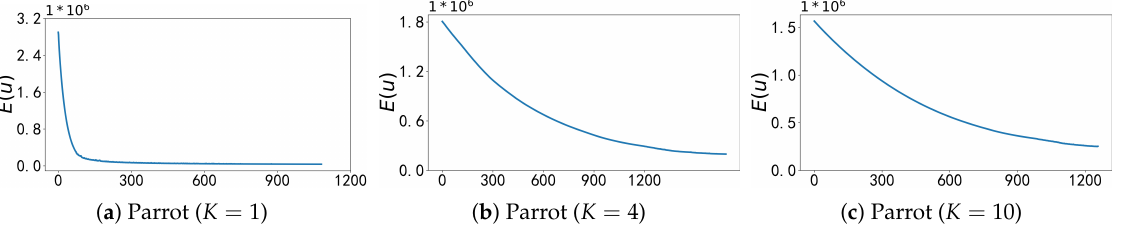
Figure 13. Plots of energy. Table 2. Comparisons of PSNR and MAE by using different denoising